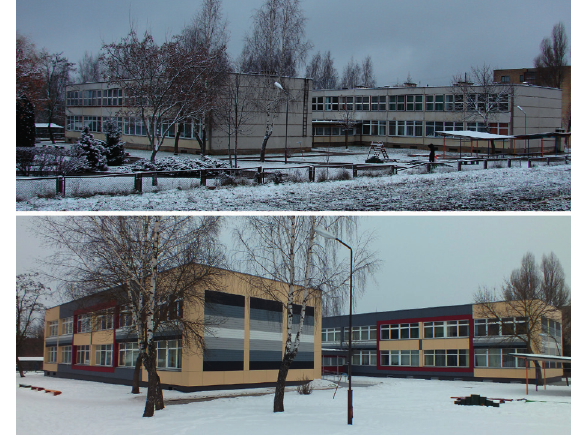
Fig. 2. Nursery school in Semeliškės before and after renovation